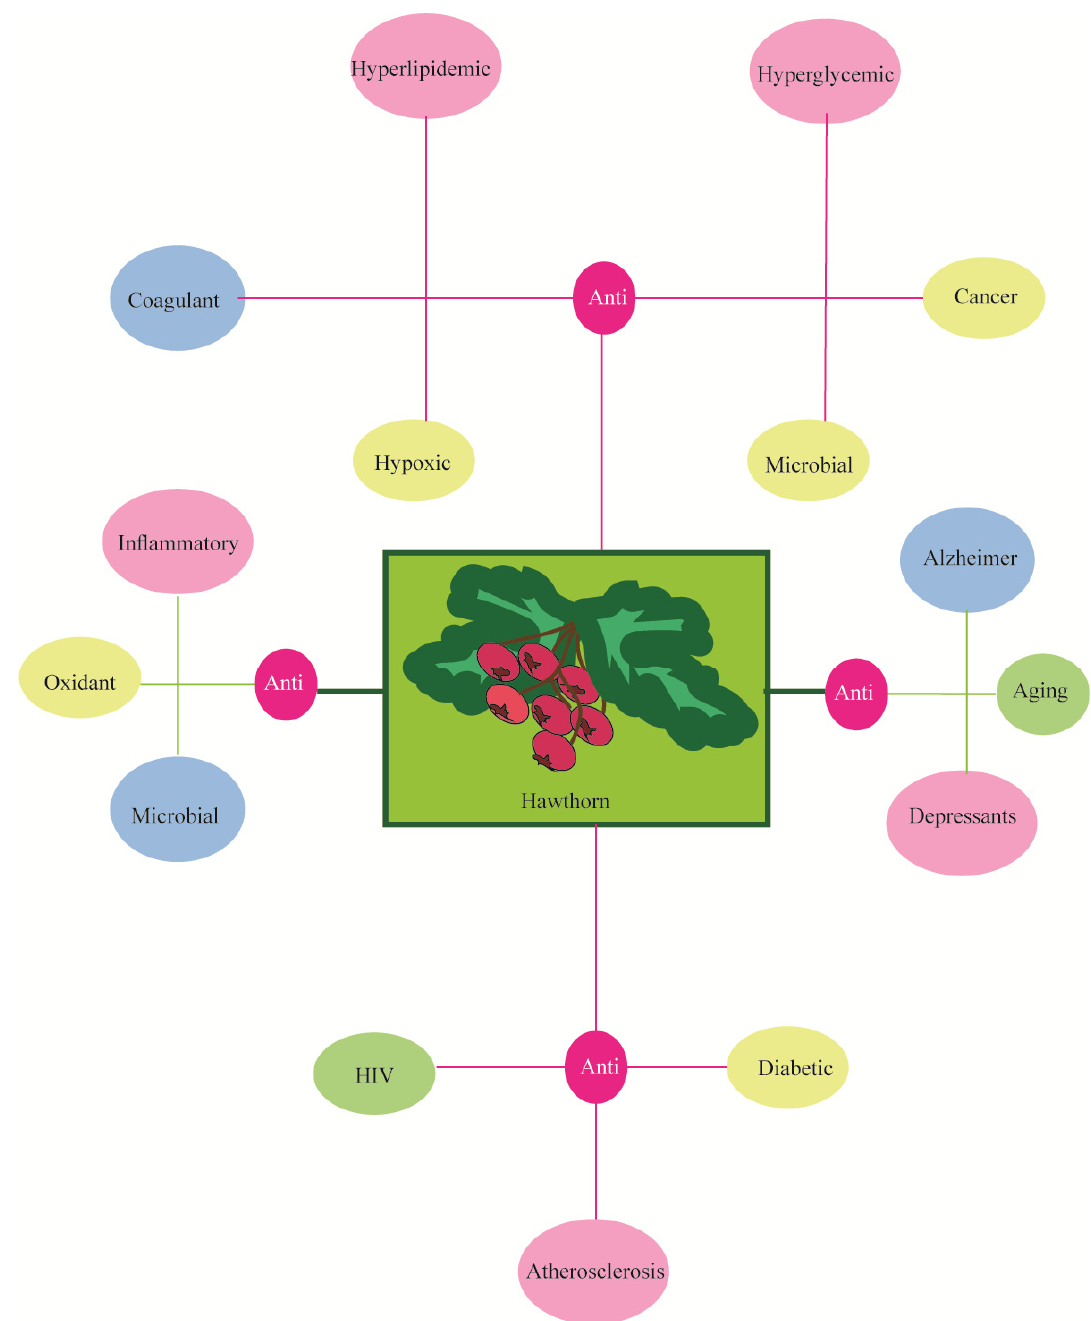
Figure 1. Scheme of the hawthorn therapeutic properties.